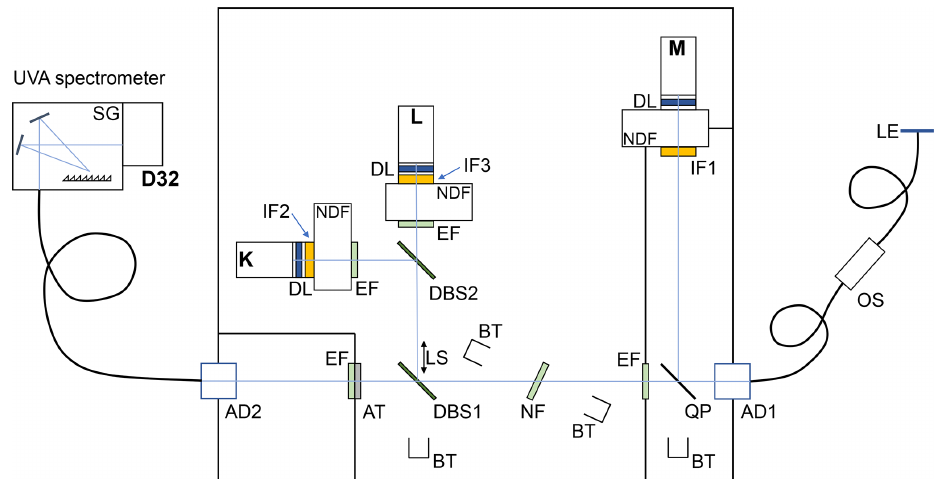
Figure 1. Schematic view of the RAMSES near-range receiver with three discrete detection channels (K–M) or, optionally, one discrete detection channel (M) and the UVA spectrometer. LE – lens, OS – optic-fiber scrambler, AD – achromatic doublets, QP – quartz plate, BT – beam traps, IF – interference filters, NDF – neutral-density filters, DL – double lenses, EF – edge filters, NF – notch filter, DBS – dichroic beam splitters, LS – linear stage, AT – attenuator, SG – spectrograph, and D32 – 32-channel